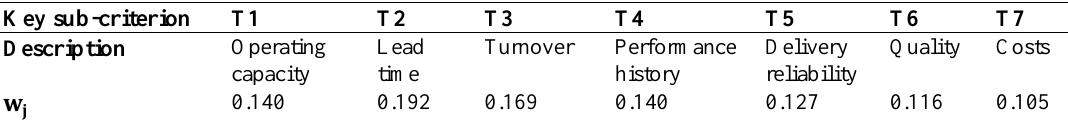
Table 12. The weight of the sub-criteria after sorting.